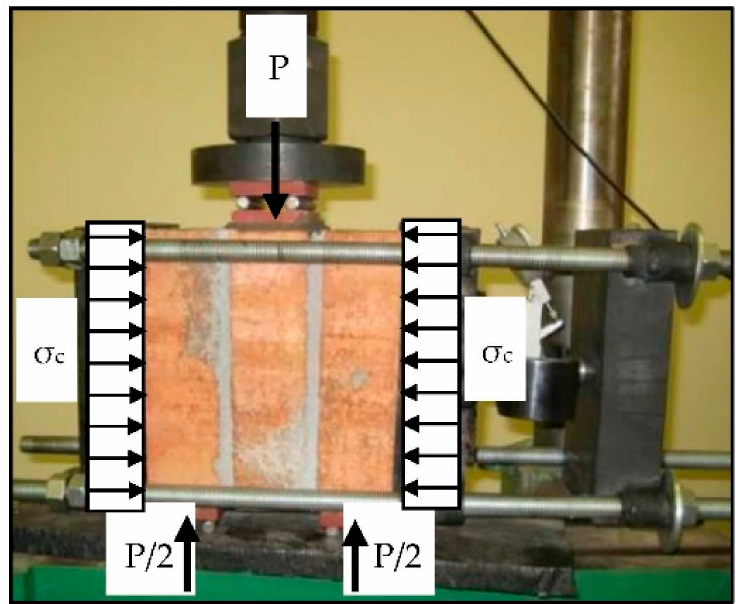
Figure 6. Testing of the initial shear strength and the internal friction coefficient of the masonry